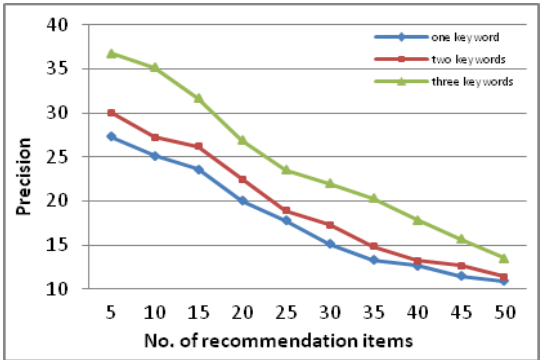
Fig 3. The value of precision Fig 4. The value of recall